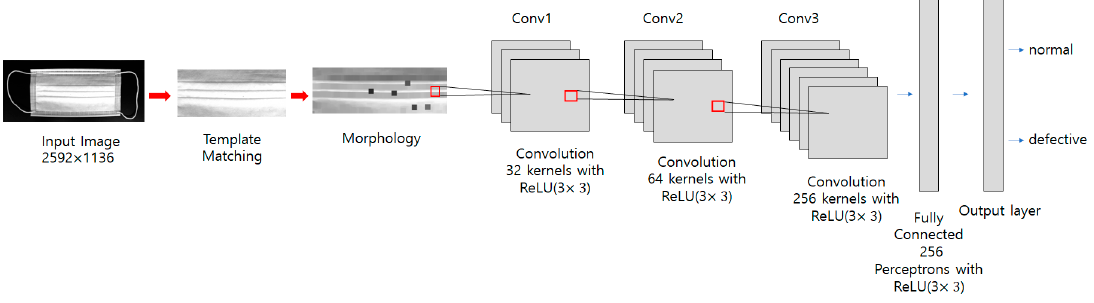
Figure 10. Preprocessing (template matching and erode operation) in dotted defect detection.